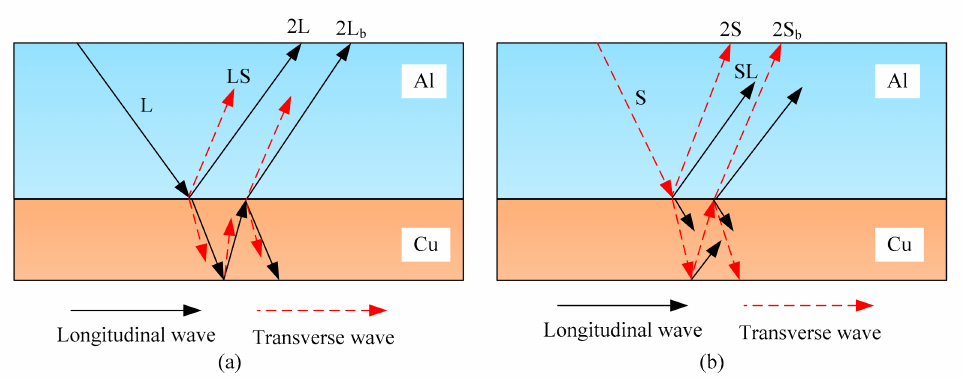
Figure 4. Reflection, refraction, and waveform conversion of ultrasonic wave oblique incident on the interface: ( a ) Oblique incidence of longitudinal waves; ( b ) oblique incidence of transverse wave.